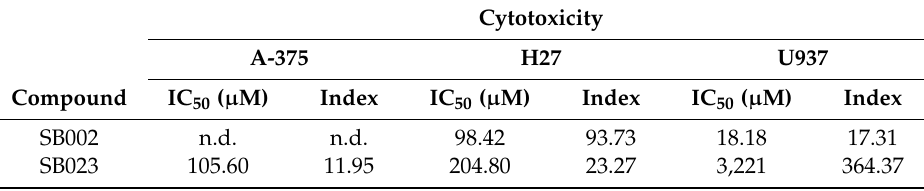
Table 3. Cytotoxic potential of SB002 and SB023 against three human cell lines, A-375, H27, and U937. The therapeutic index compares the cytotoxicity results with results obtained from the dose-response inhibition of P. aeruginosa growth in M9 acetate medium (Figure S3) (IC 50 cytotoxicity / IC 50 P. aeruginosa growth